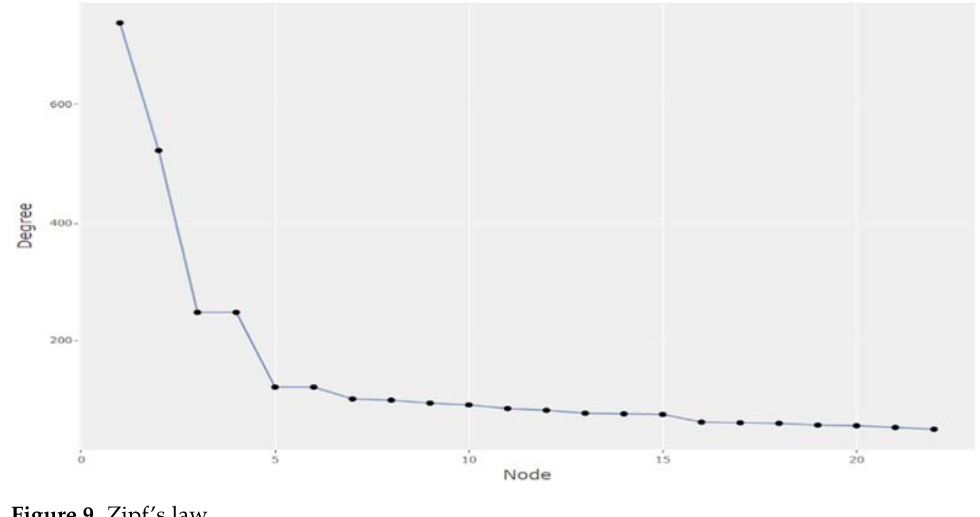
Figure 9. Zipf’s law.